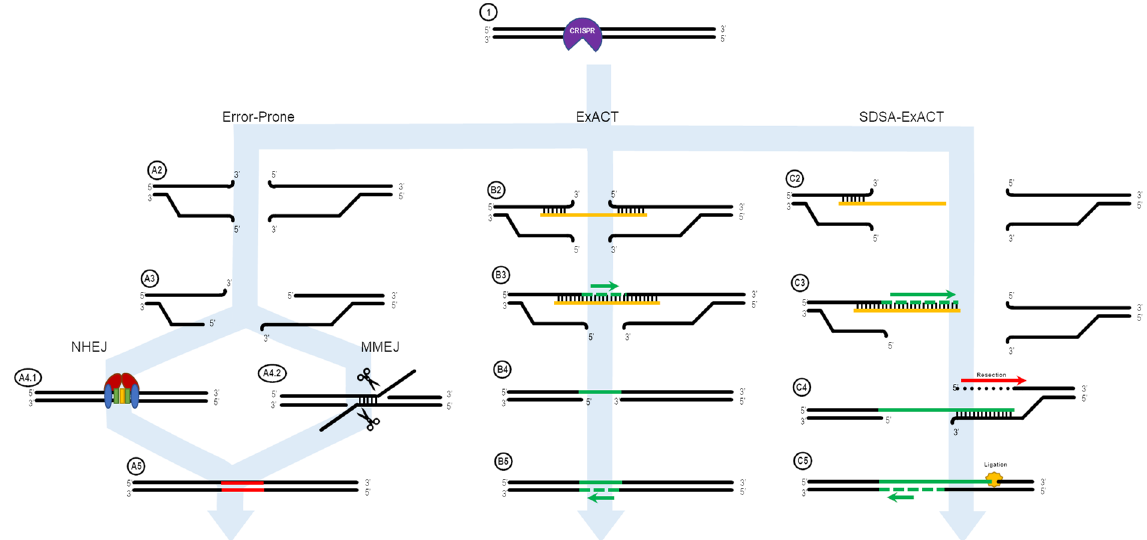
Figure 5. A more comprehensive ExACT pathway. This redesigned ExACT pathway incorporates the two-step gap bridging mechanism and depicts the possibility for overlap between the multiple branching arms of the pathway. After CRISPR-Cas cleavage ( 1 ), the complex dissociates from the DNA. In the local absence of ssODN repair templates, the DNA ends are resected ( A3 ). NHEJ and MMEJ occur to repair and relegate the broken DNA ends ( A4.1 and A4.2 ), resulting in an error-prone final product containing indels. In the presence and accessibility of a repair ssODN, the oligo will either bind to both or just a single end of the broken DNA ( B2 and C2 , respectively). If both ends are stabilized by the ssODN, DNA synthesis and ligation to the opposite end are performed concurrently via DNA synthesis ( B3 ). Once the oligo the dissociates ( B4 ), the repaired strand can then be used as a template for a second synthesis step, repairing the other strand ( B5 ). If only a single end associates with the ssODN, synthesis occurs from the 3 ′ end of the broken DNA, extending it using the ssODN as a template ( C3 ). This extended end can then, once the oligo dissociates, bind to the opposite end of the cut site and bridge the DNA break. At this time or previously, the S strand of the downstream end is resected in a 5 ′ > 3 ′ direction ( C4 ). Finally, the now-bridged DNA can be repaired via synthesis using the newly-synthesized upstream sequence as a template via a second round of synthesis. The final DNA break is then repaired wither via simple ligation or extension and ligation of the S strand sequence ( C5 ).